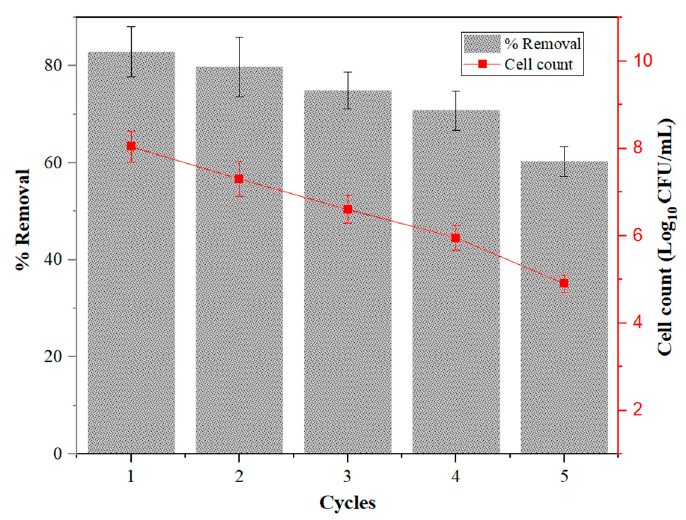
Figure 12. Reusability study of PSDB for Ni 2+ removal.